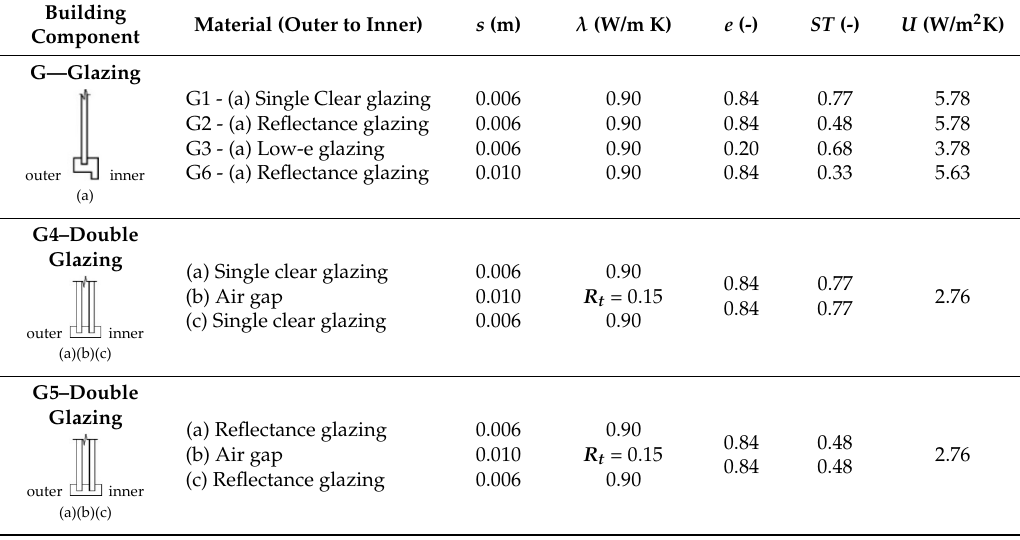
Table 3. Description of glazing type considered. For each layer, the values of s (thickness), λ (thermal